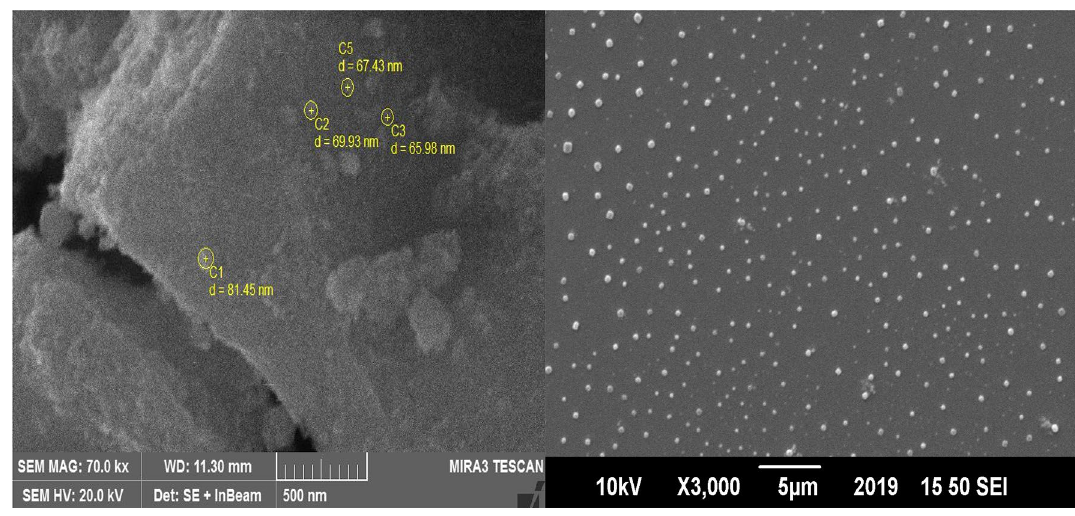
Figure 2. SEM images of NiFe 2 O 4